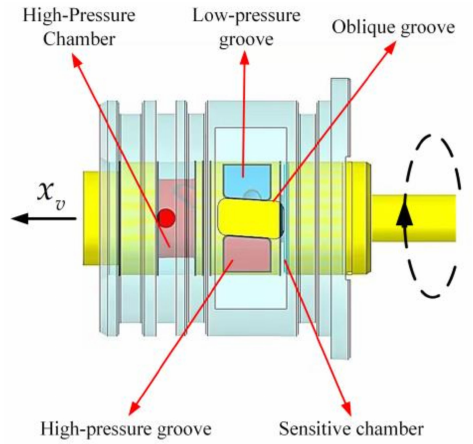
Figure 2. Schematic diagram of 2D piston